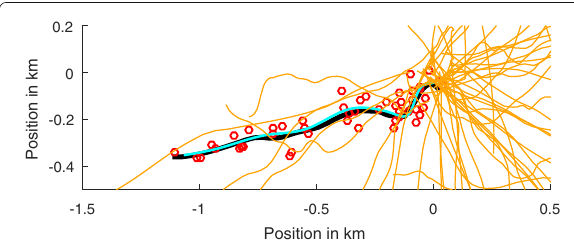
Fig. 7 Illustration of a representative trajectory ( black ), the RTS smoothing solution ( cyan ), and an initial ensemble ( N = 50, orange ). Redcircles depict the measurements. Most ensemble trajectories go beyond the plot area